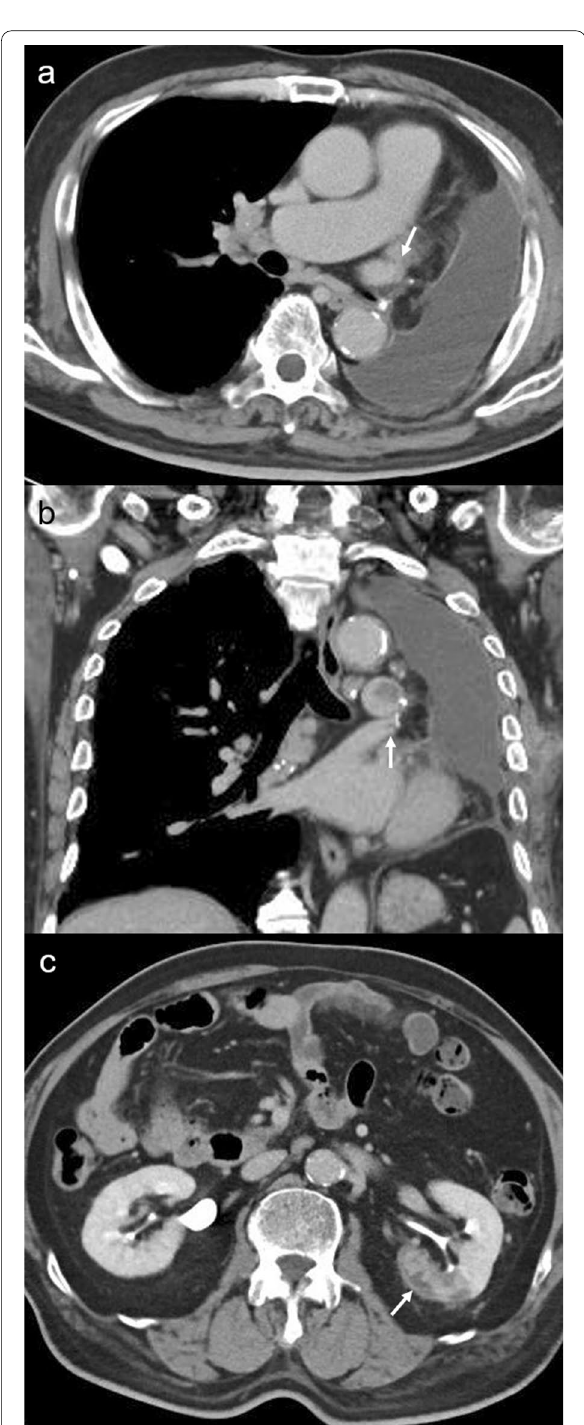
Fig. 3 A contrast-enhanced computed tomography on postoperative day 19 reveals a reduction of the thrombus in the left upper pulmonary vein stump: a coronal view, b horizontal view, and c recovery of the partial defect of the left